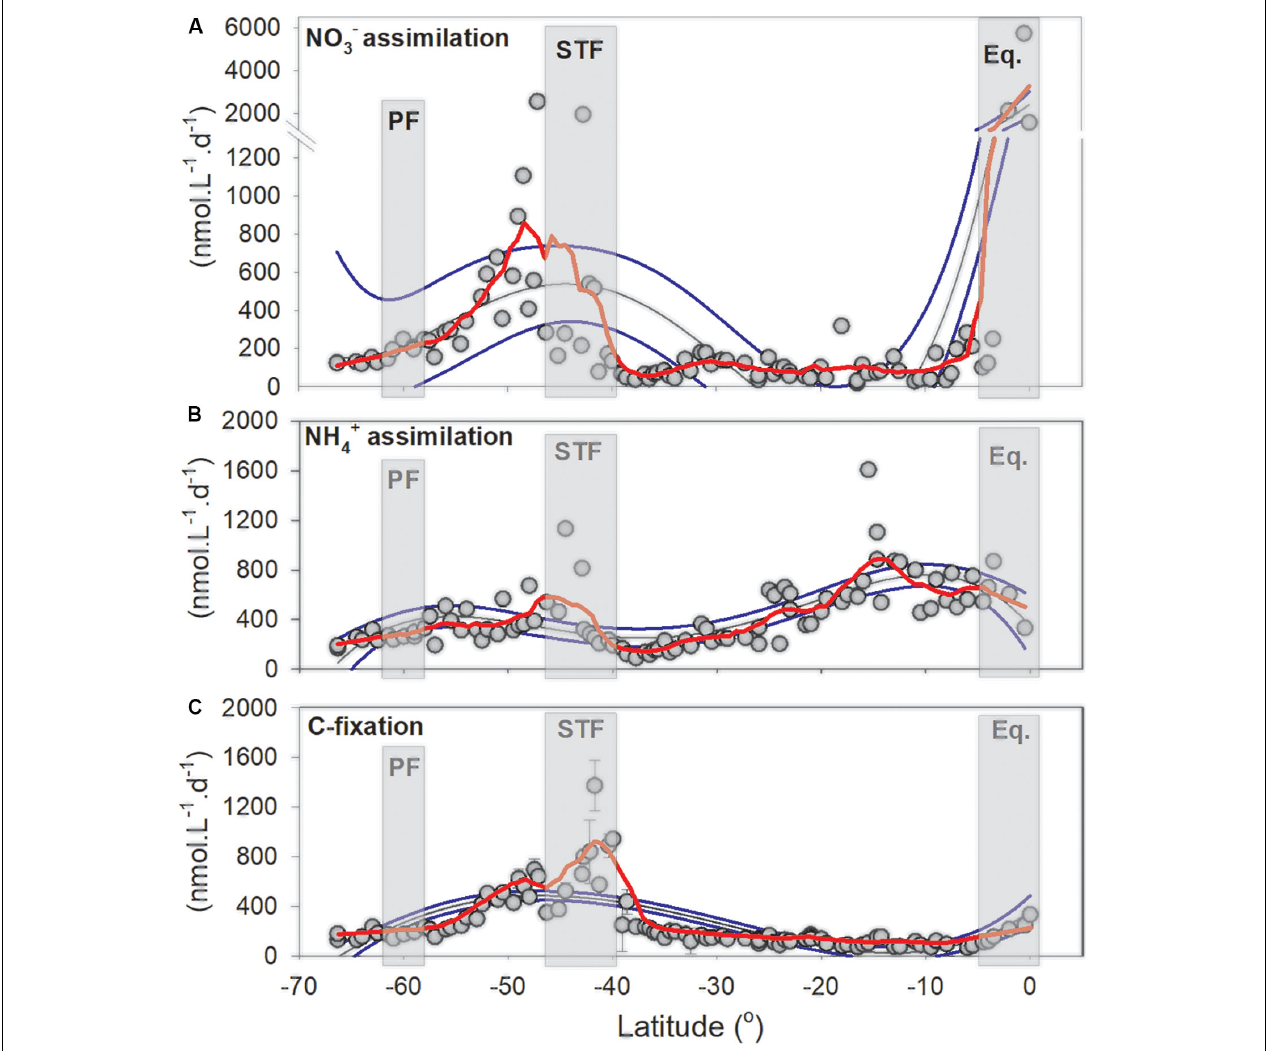
FIGURE 7 | Nitrogen assimilation and primary productivity in the South Pacific Ocean. (A) NO 3 − and (B) NH 4 + assimilation rates and (C) Primary productivity rates (in nmol L − 1 d − 1 ) with standard deviation ( n = 3). Red lines are negative exponential smoothing curves with a first polynomial order. Thin black lines are fourth order polynomials and thin blue lines 95% confident intervals. Gray rectangles denote oceanographic fronts (PF, Polar front; STF, Subtropical Front; Eq, Equatorial upwelling